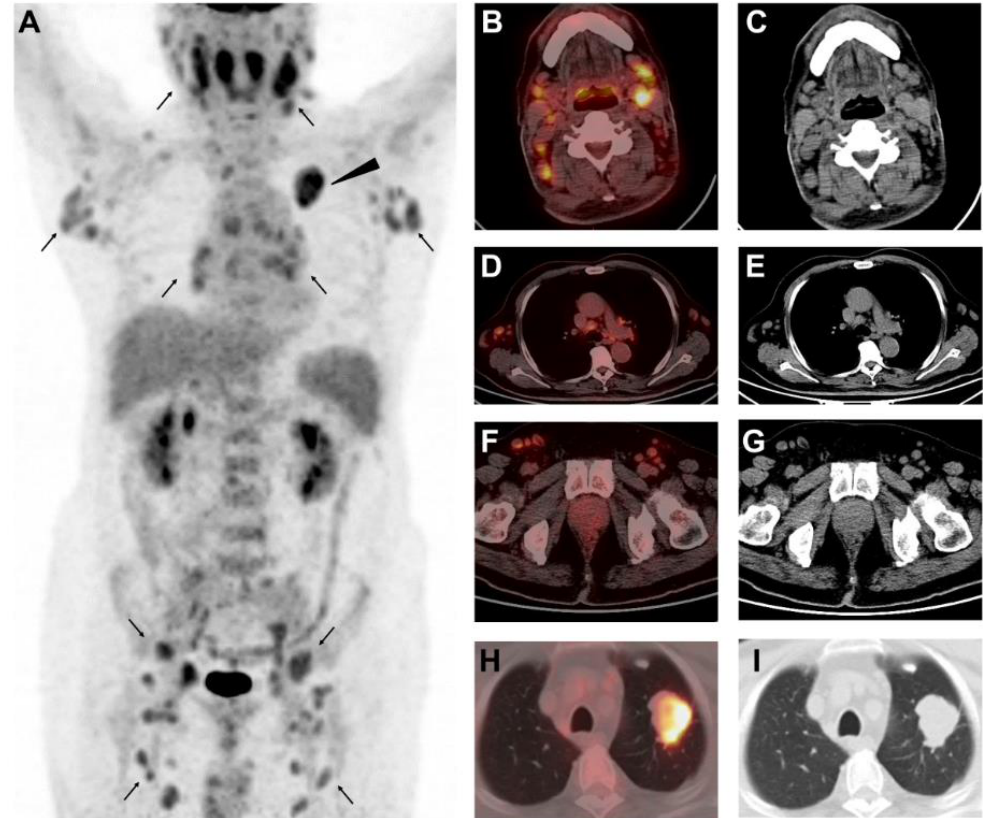
Figure 1. An 82-year-old man presented with cervical lymphadenopathy and low-grade fever for 3 weeks. He had a history of colon cancer (pT3N1bM0) and underwent right hemicolectomy followed by three cycles of chemotherapy 3 years ago. Laboratory examination showed elevated serum carcinoembryonic antigen (CEA, 24.9 ng/mL, normal range, 0 – 5.0), and contrast-enhanced CT detected a pulmonary mass and enlarged lymph nodes in the chest and abdomen. Fluorine-18 fluorodeoxyglucose positron emission tomography/ computed tomography ( 18 F-FDG PET/CT) was performed for suspicion of metastasis from colon cancer. The MIP of PET ( A ) and axial fusion and CT images ( B – G ) showed multiple FDG-avid nodes symmetrically distributed in the cervical, mediastinal, axillary, retroperitoneal, pelvic, and inguinal regions ( A – G , arrows, SUVmax 7.6). Additionally, an FDG-avid mass was noted in the left upper lobe of the lung ( A . arrowhead, SUVmax 7.2; ( H , I ), axial fusion and CT image, lung window). Based on his history and serum CEA level, pulmonary metastasis from colon cancer was first suspected. The lymphadenopathy was generalized, hypermetabolic and symmetrically distributed, though voiding colic or mesentery lymph nodes. Such presentation was not characteristic of lymph node metastases from colon cancer; instead, they were more likely to be related to hematological disorder, such as lymphoma (adapted from [1]) or multi-center Castleman disease (adapted from [2]), or systemic inflammatory disease, such as virus infection [3], typhoid fever (adapted from [4]), sarcoidosis (adapted from [5]), necrotizing lymphadenitis [6], IgG4-related disease [7], and adult-onset Still ’ s disease (adapted from [8]).